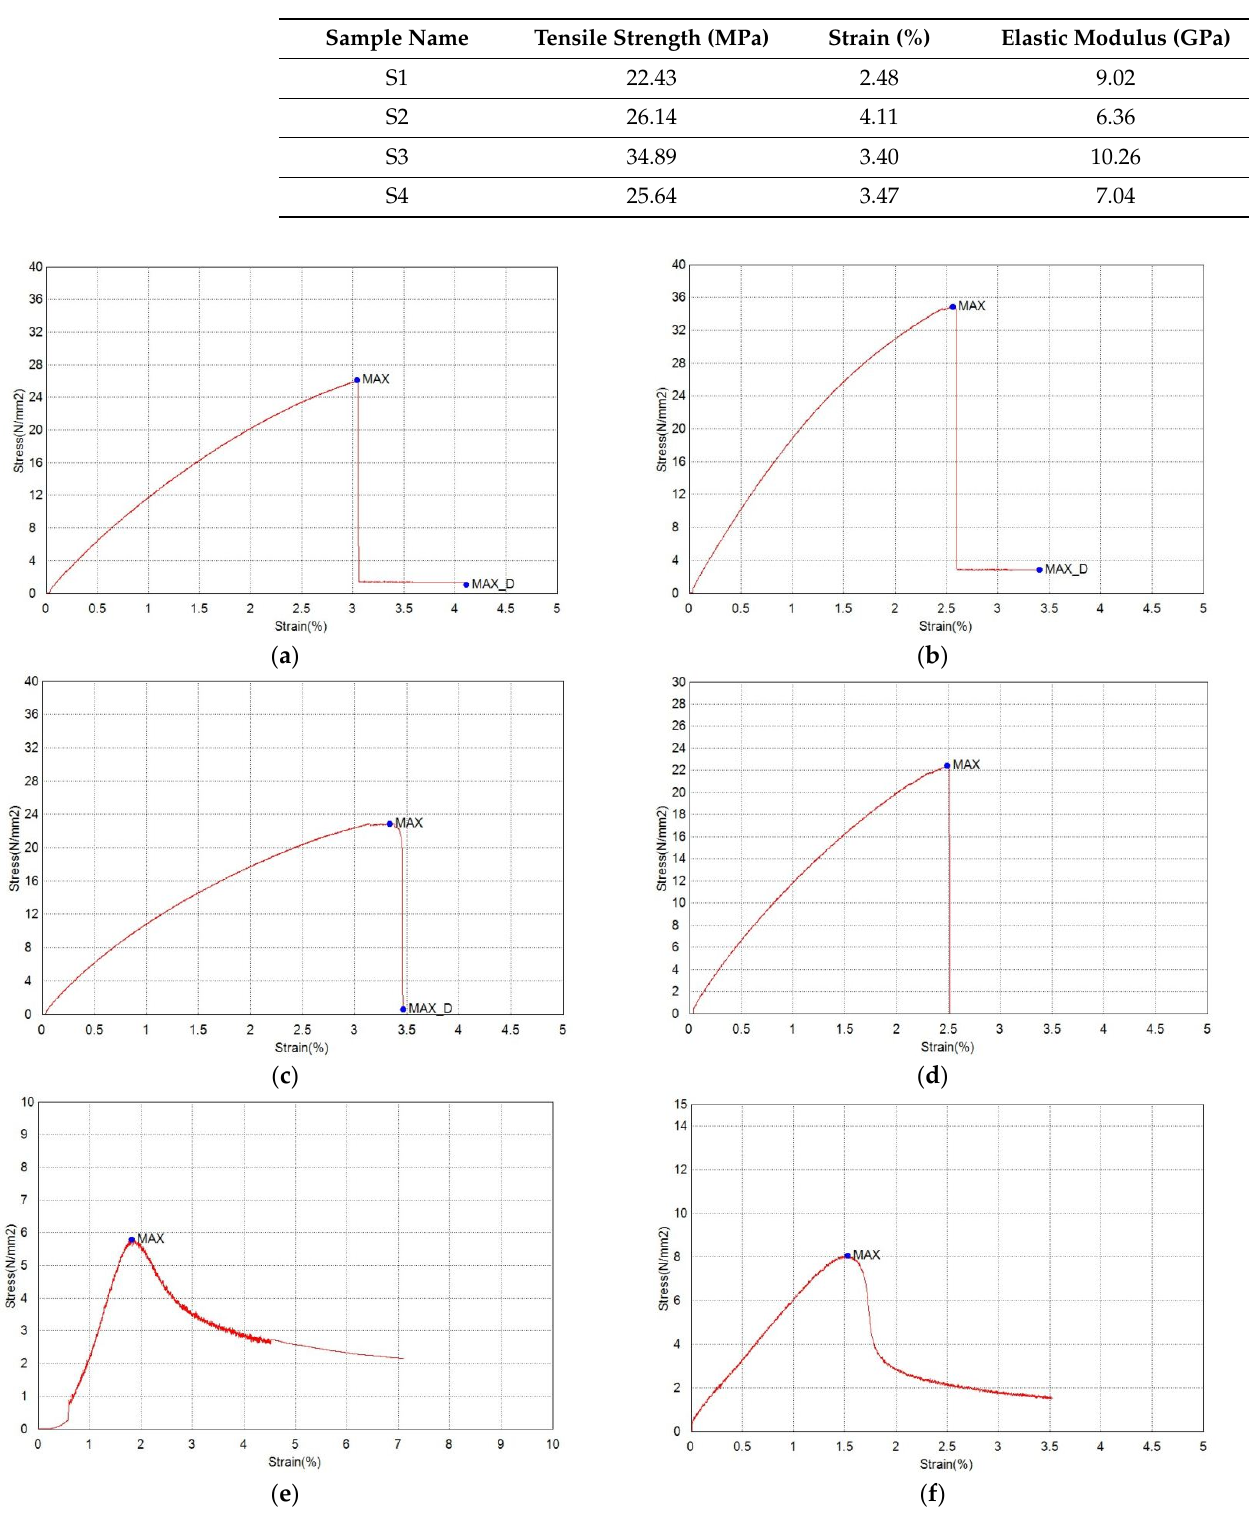
Table 4. Tensile properties of JCJC spent tea leaf composites.